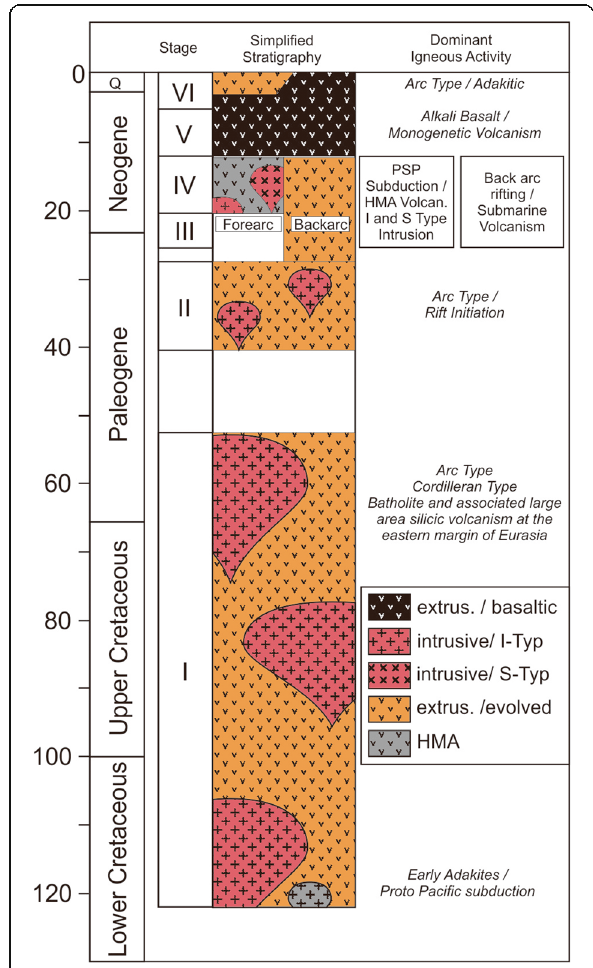
Fig. 4 Simplified stratigraphic evolution of the SW Japan arc. Individual stages are described in the text. HMA - High Magnesian Andesite, AD - Adakite are hallmarks of subduction initiation of a new young plate. Stage IV shows distinct evolution between for-arc and back-arc. See text for detailed description of individual stages and further